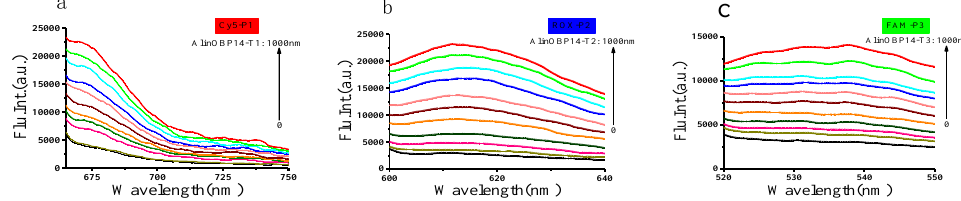
Figure 1. The PNA-GO-based nanocomplex solution (mRNA biosensor) was mixed with chemically synthesized targets of various concentrations (0–1000 nM). The fluorescence signals intensified as the concentration of added targets increased. ( a ) Target mRNA: AlinOBP14-T1. The excitation wavelength was 643 nm. ( b ) Target mRNA: AlinOBP14-T2. The excitation wavelength was 575 nm. ( c ) Target mRNA: AlinOBP14-T3. The excitation wavelength was 494